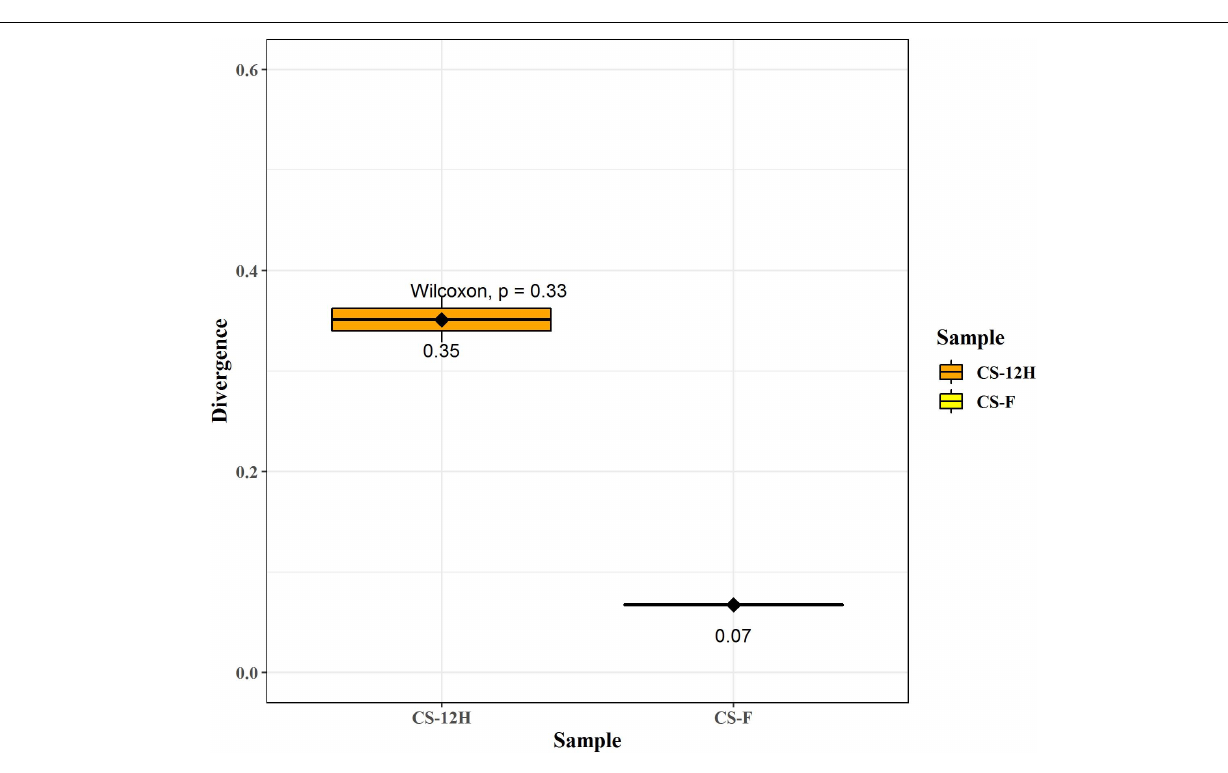
FIGURE 7 | This figure represents group divergence/spread of the given sample set for fungal reads. Here, CS-F (fresh Kalparasa ) sample divergence is 0.07, whereas CS-12H (12-h fermented Kalparasa ) sample divergence is 0.33. These can be compared between groups in order to compare differences in group